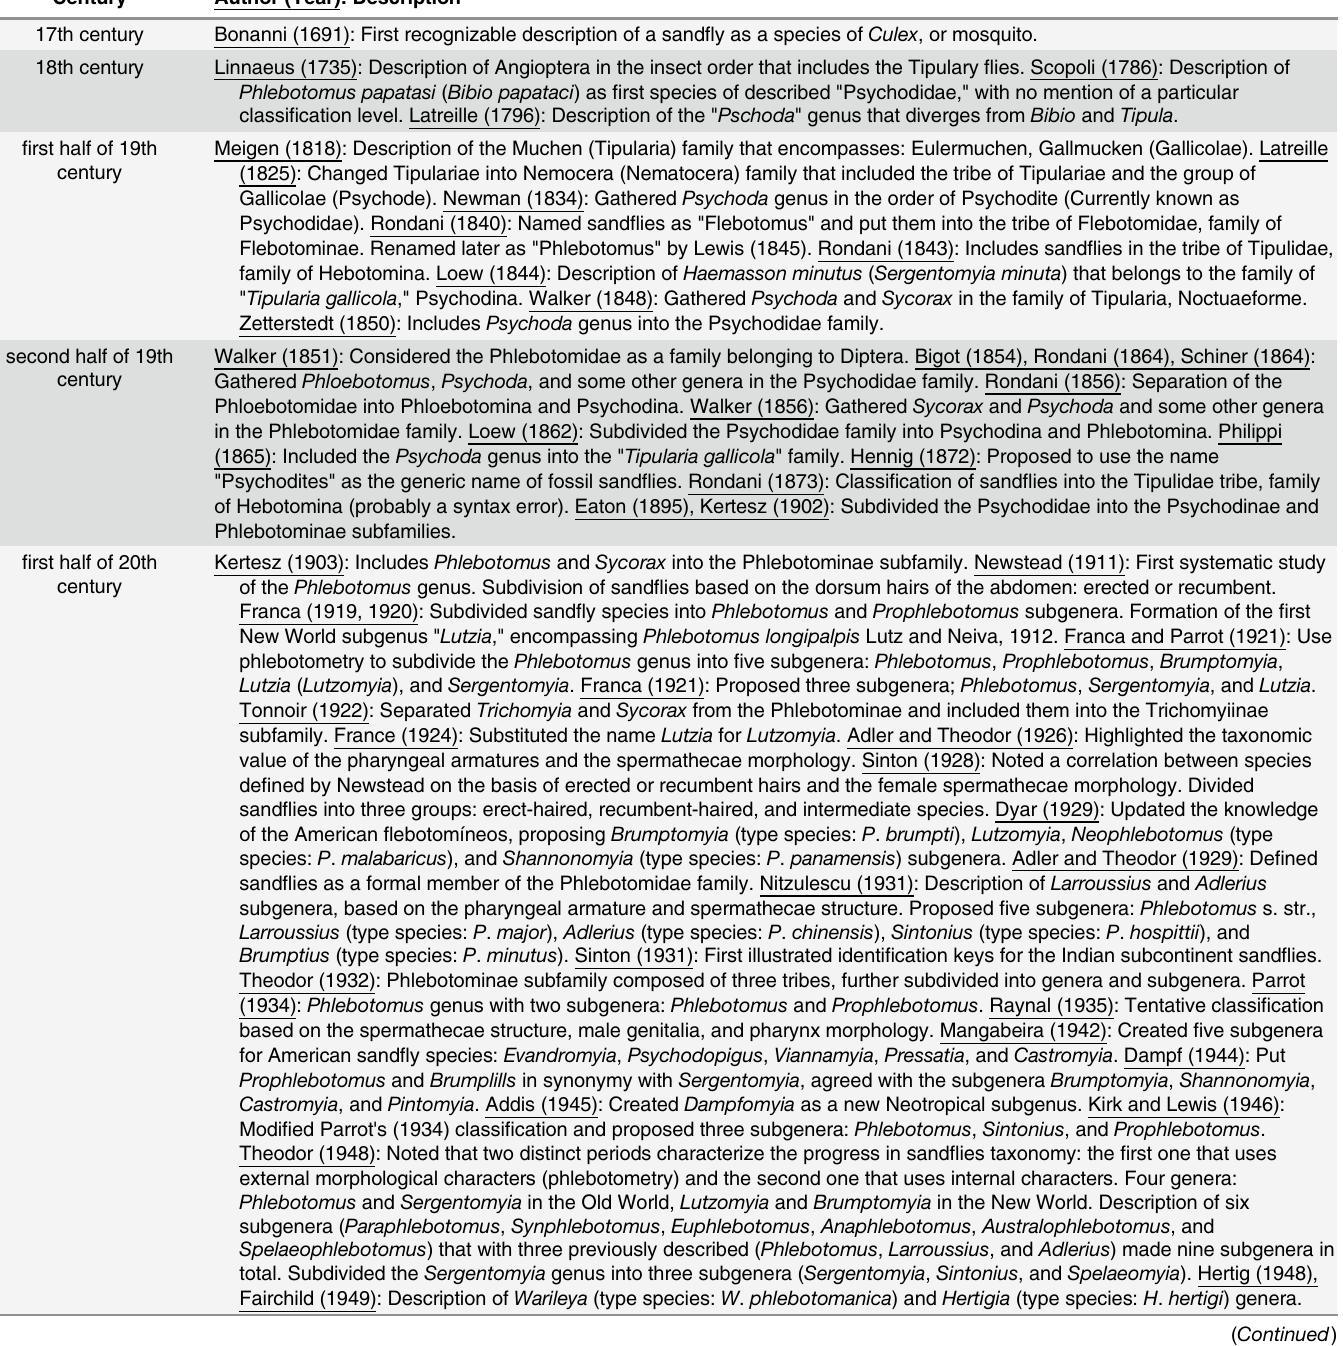
Table 2. History of sandfly